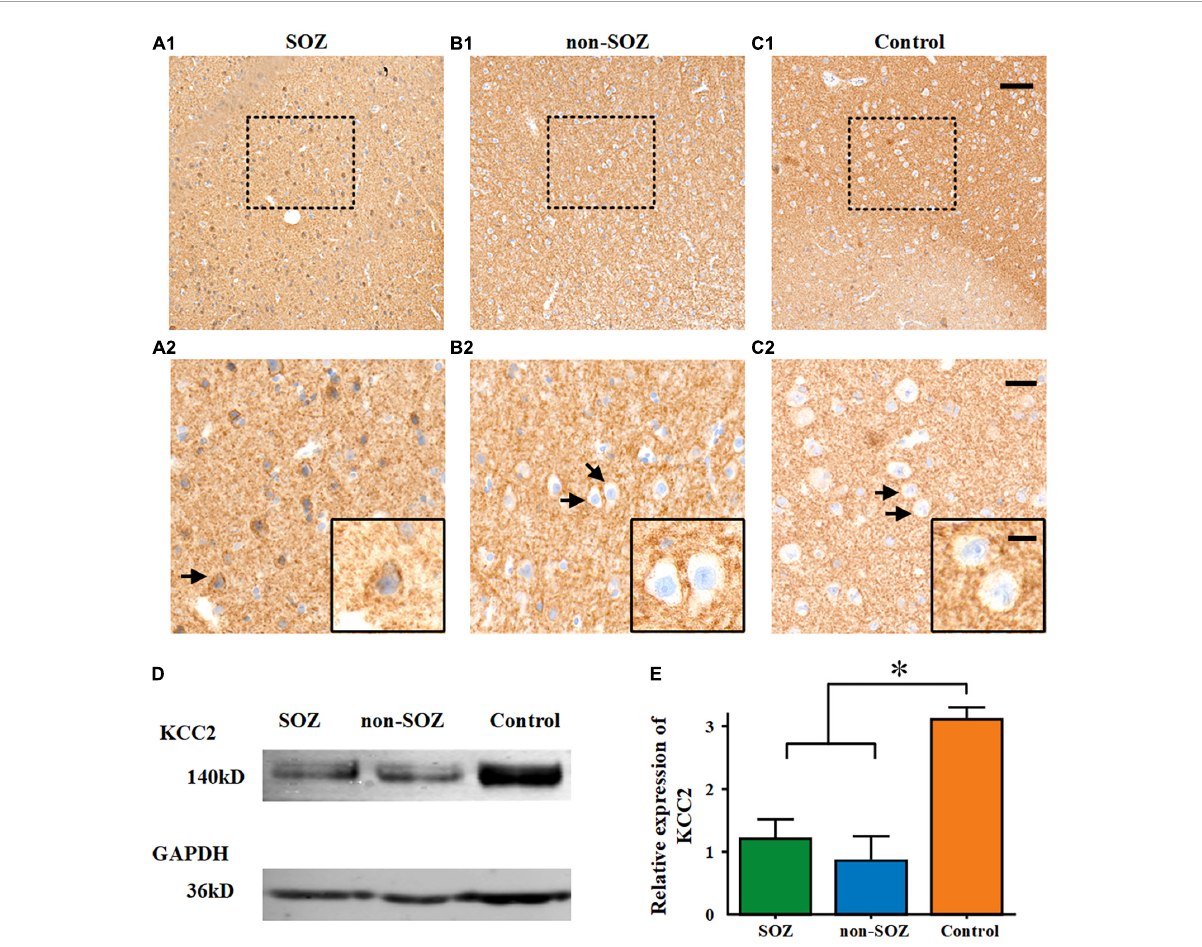
FIGURE5 Comparison of KCC2 expression across all three groups. A diaminobenzidine reaction product was used for the immunohistochemical detection of KCC2 using a hematoxylin counterstain. (A–C) Sub-cellular KCC2 distribution in the three groups. High peri-somatic KCC2 localization was assessed in the SOZ of patients with FCD and epilepsy. Cytoplasmic expression was absent in the non-SOZ of the same patient and the control group. (A2–C2) Represent magnified images of the enclosed areas in (A1–C1) . Black frames in (A2–C2) depict different sub-cellular KCC2 distribution (arrows). Scale bars represent 100 µ m for (A1–C1) , 30 µ m for (A2–C2) , and 10 µ m for the black frame in (A2–C2) . (D,E) Expression in total homogenates from specimens in SOZ, non-SOZ, and control groups. Expression of GAPDH (as a reference protein) as seen in the same protein extracts. * p < 0.05. Data was shown as mean ±